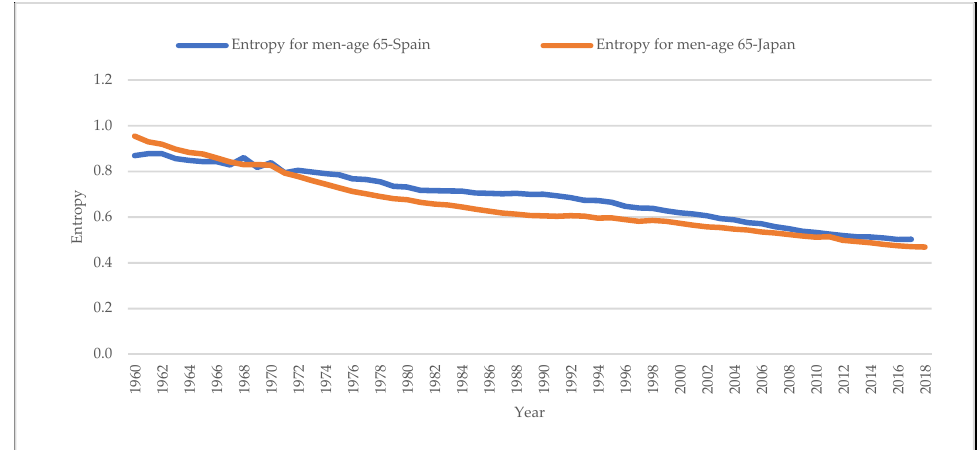
Figure 8. Entropy evolution for the male population at 65 over calendar years. Source: authors.